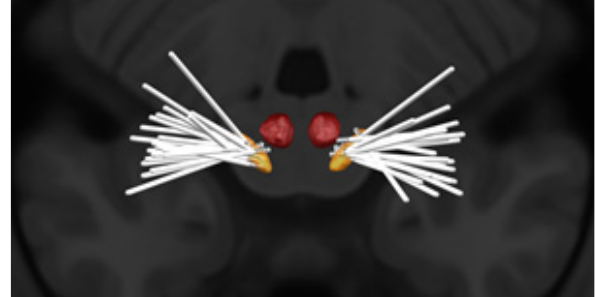
Fig. 2. Group level visualisation (Lead-DBS toolbox v2.2.3).